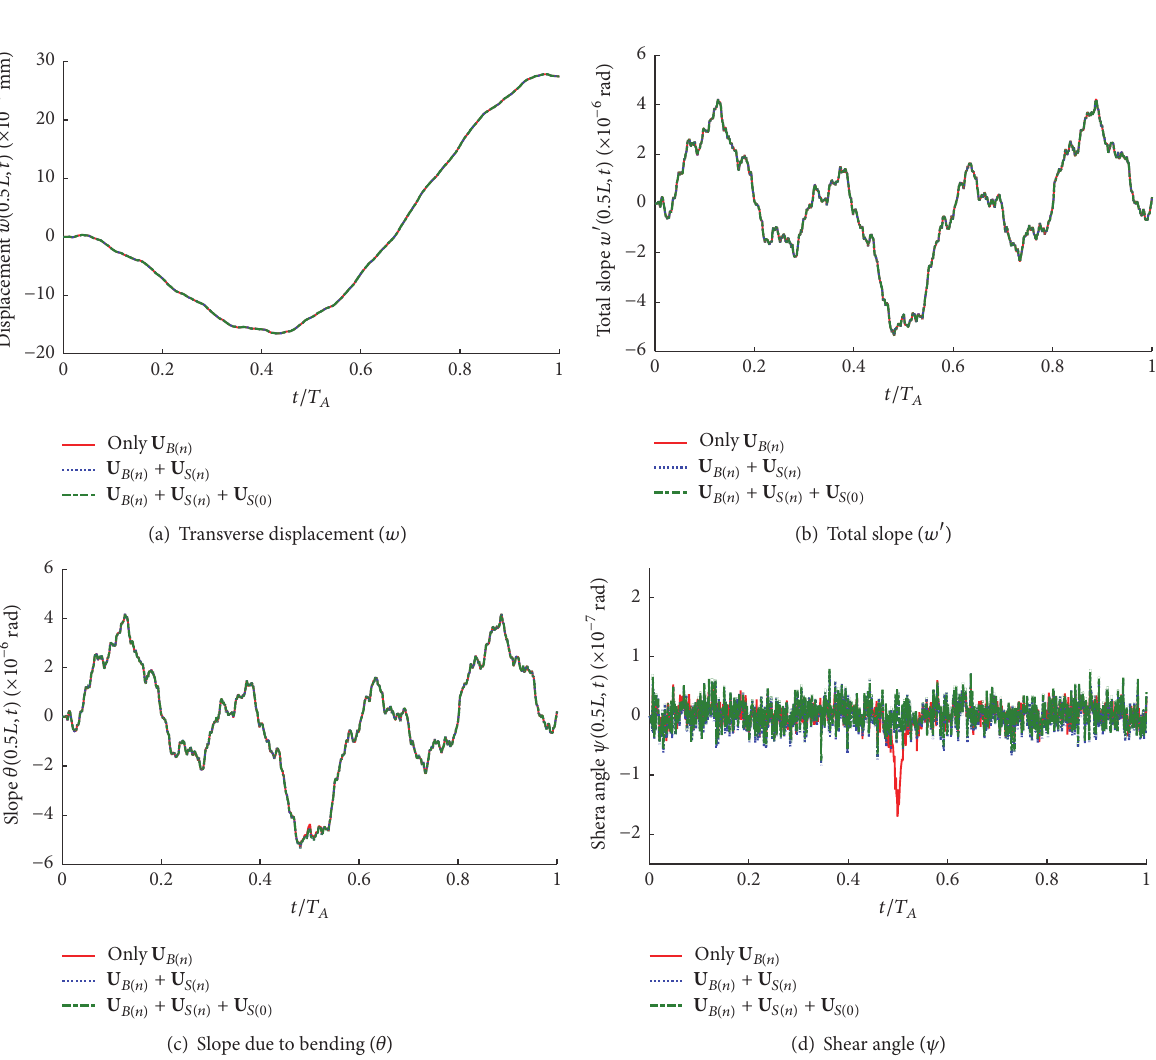
Figure 10: Dynamic responses at 𝑥/𝐿 = 0.5 of a simply supported Timoshenko beam subjected to a point bending moment moving at a constant speed of V 𝜏 = 0.5 V cr : (a) transverse displacement (𝑤) ; (b) total slope (𝑤 󸀠 ) ; (c) slope due to bending (𝜃) ; (d) shear angle (𝜓)